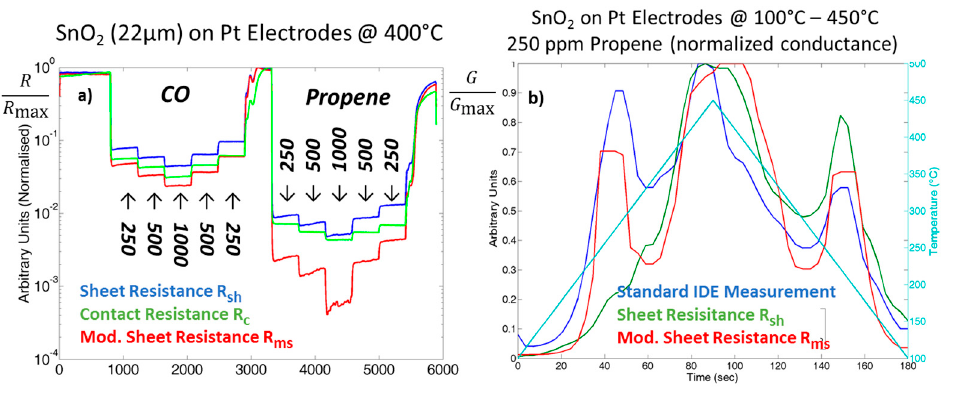
Figure 3. ( a ) Specific responses of the marked areas of the sensor, compared by the corresponding normalized resistance values. The normalized and area separated conductance contributions over a temperature cycle (CTP) for 250 ppm propene is given in ( b ).